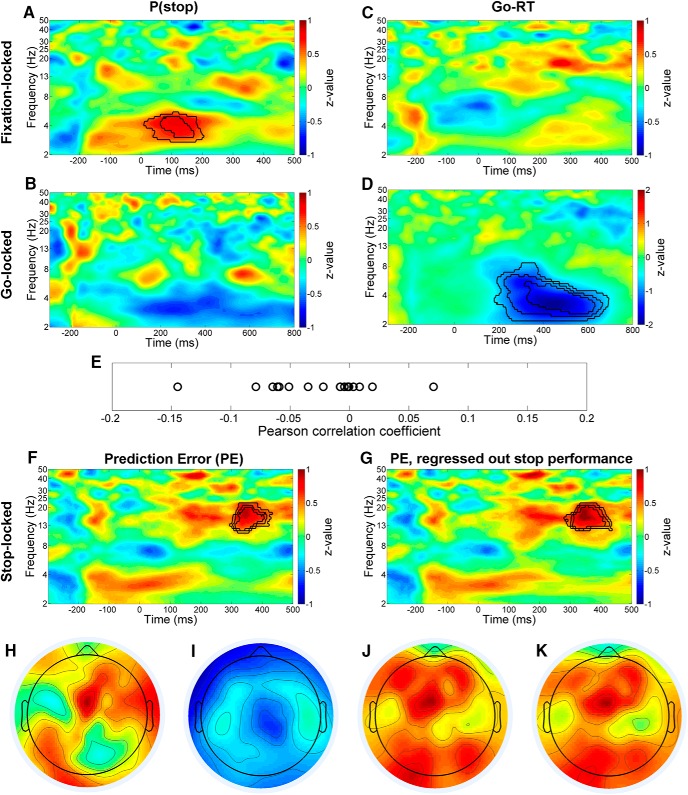
Trial-by-trial oscillatory power correlates of P(stop), go-RT, and PE at channel FCz. A, Correlation between fixation-locked (onset at 0 ms) power and P(stop) at each time–frequency bin. The color represents the z-value of Spearman correlation, and the black contours represent statistically significant time–frequency clusters in the nonparametric cluster-based permutation test across participants, with clustering threshold at p < 0.02, 0.005, and 0.001 levels (see Materials and Methods for details). It showed a positive correlation in the intervals 3–5 Hz and 0–200 ms. B, No clusters showed a significant correlation between go-locked power and P(stop). C, No clusters showed a significant correlation between fixation-locked power and go-RT. D, Correlation between go-locked power and go-RT, with the permutation test showing a negative correlation in the intervals 2–8 Hz and 200–700 ms. E, The coefficient of trial-by-trial Pearson correlation between the mean power of the clusters identified in A and D of individual participants. Wilcoxon signed rank test showed that the correlation coefficients across participants were significantly below zero. F, G, Correlation between stop-locked power and PE, with the permutation test showing a positive correlation in the intervals 12–22 Hz and 300–400 ms. The topographies of each correlational cluster (p < 0.005) are shown in the bottom panel, where H, I, J, and K each show the cluster of A, D, F, and G, all with the strongest correlations at the midfrontal region. We performed the same analyses at Pz channel (Fig. 2-1).